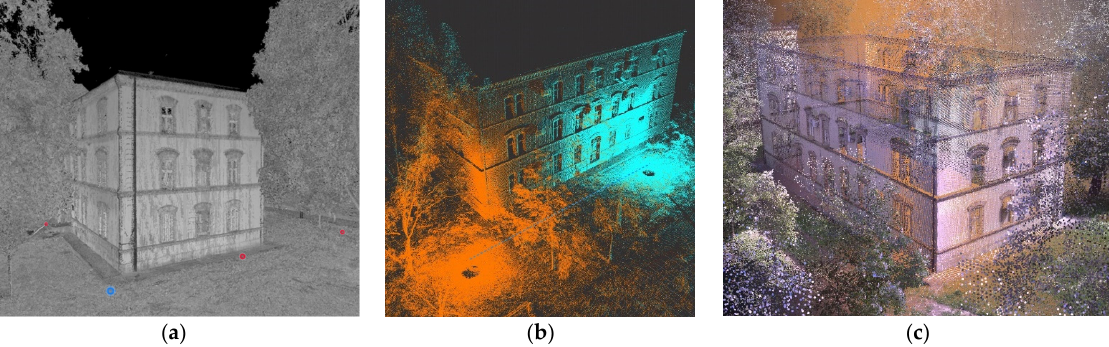
Figure 6. ( a ) Display of laser scanner measuring points Leica BLK 360; ( b ) Presentation of the laser scanning model; ( c ) Cyclone Register model.